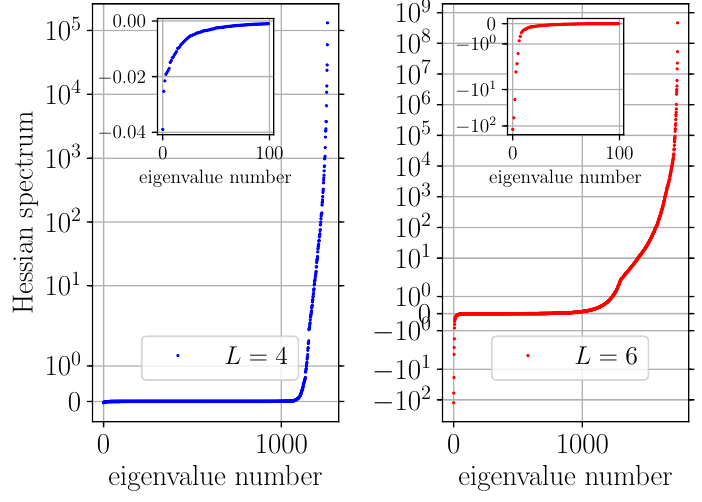
Figure 11: Hessian matrix eigenvalues of the energy cost function, see App. G: full- = − 8.457917 (blue), and basis simulation for N = 4 × 4 at iteration 499 where E gs = − 18.073818 (red). Inset: zoom over the N = 6 × 6 at iteration 675 where E gs first 100 eigenvalues. The few negative large eigenvalues at N = 6 × 6 indicates the presence of highly curved narrow directions in the energy landscape, which appear hard for VQMC to find. They are responsible for the slowing down of the rate at which / J = 0.5. energy improves. The network architecture is listed in App. H, and J 2 1 Optimization was done using RK in combination with SR, see App.